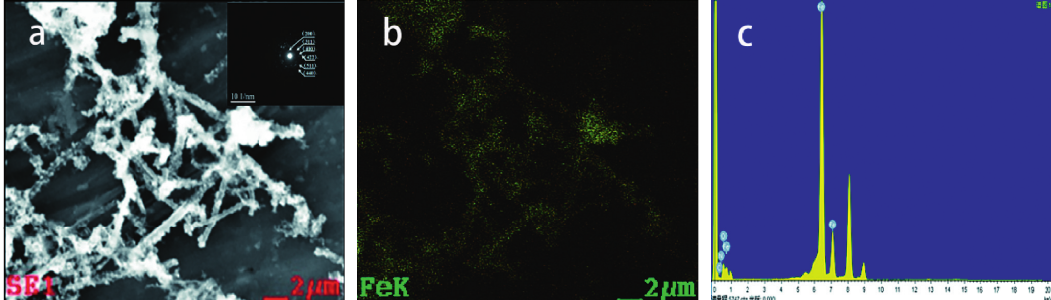
Figure 4: SEM pattern (a), Fe distributing (b), and EDS profile (c) of S2.